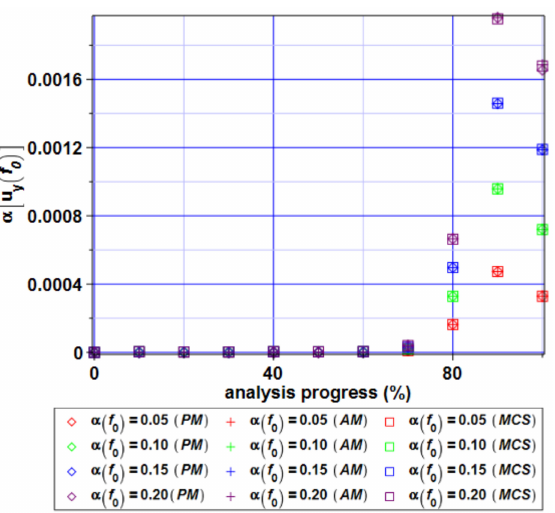
Figure 20. Coefficient of variation of the extreme vertical displacements α [u y (f 0 )] for the beam.